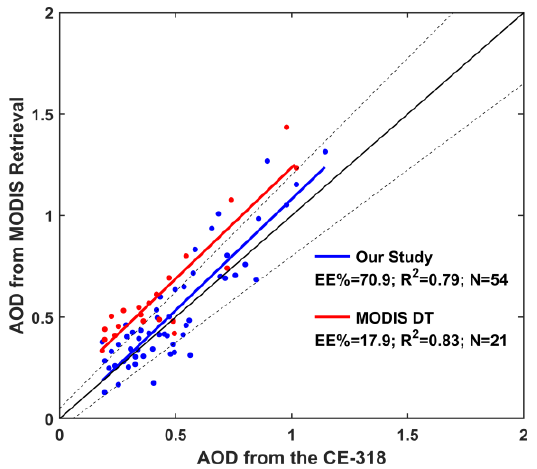
Figure 6. Validations of retrieved AOD of our study (blue) and MODIS 10 km DT products (red), against with ground-based measurements by CE-318. The EE% means expect error (%) and the N is matching number of